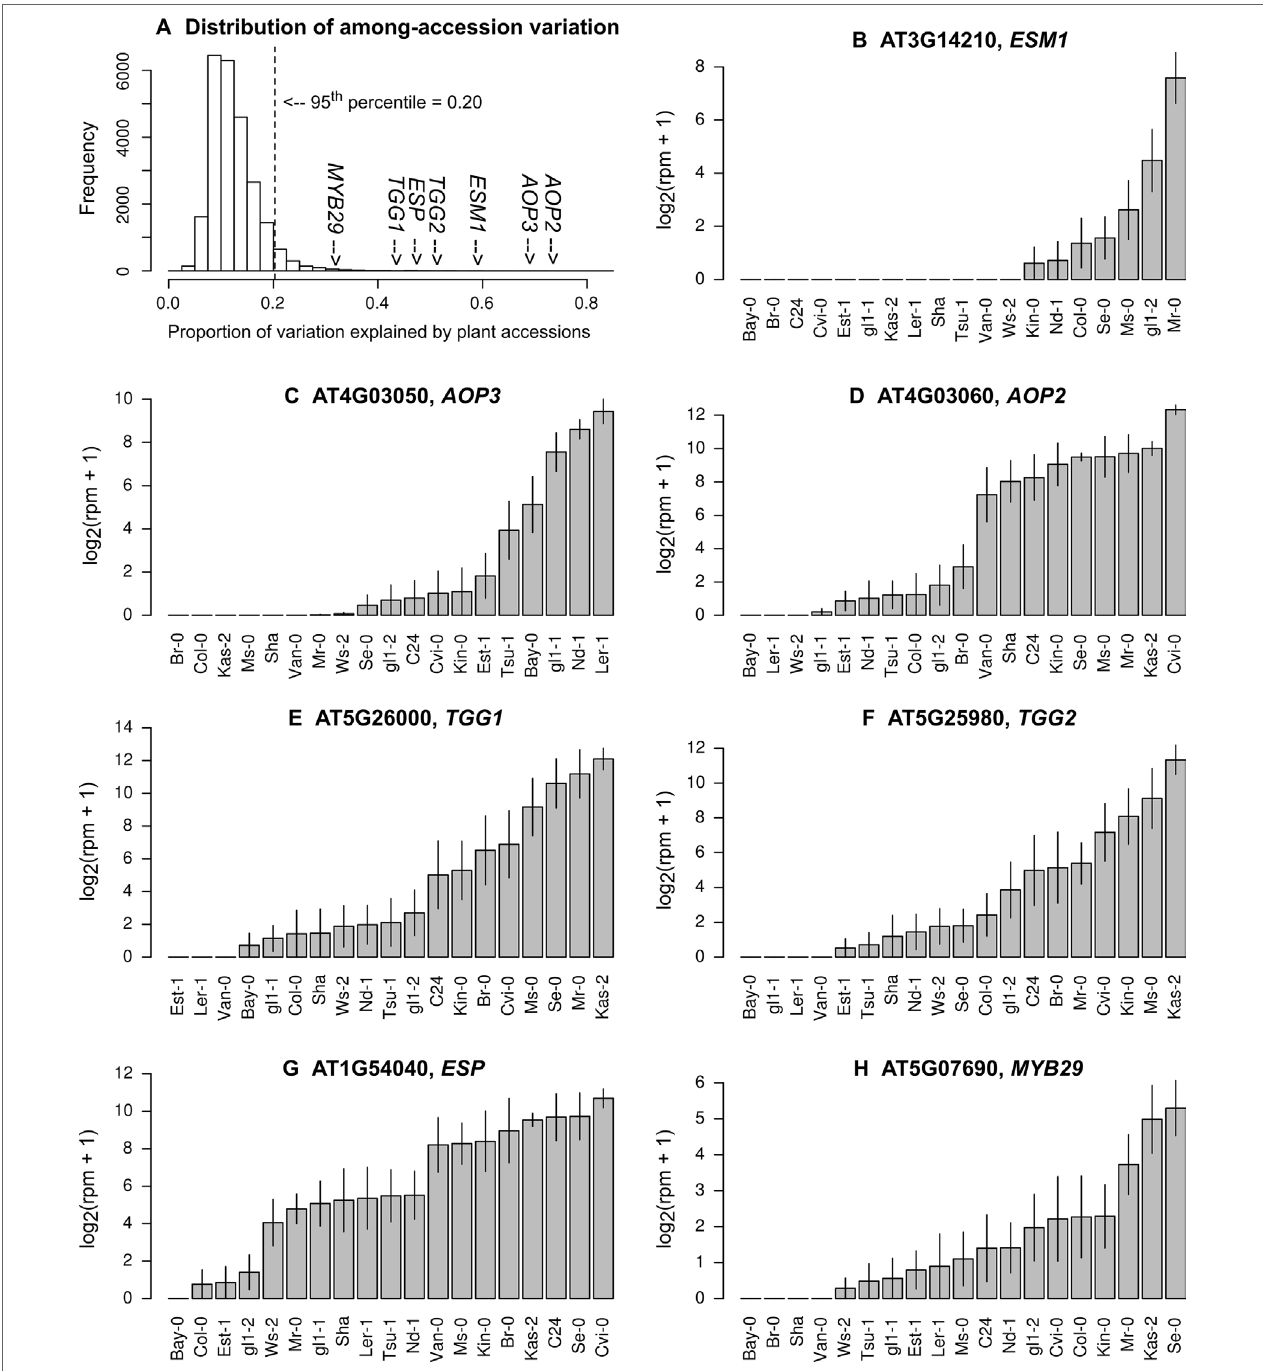
FIGURE 2 | Natural variation in the expression levels of genes involved in glucosinolate biosynthesis and hydrolysis. (A) Histogram showing the proportion of variation explained by plant accessions, (B) the expression of ESM1 , (C) AOP3 , (D) AOP2 , (E) TGG1 , (F) TGG2 , (G) ESP , and (H) MYB29 . Grey bars and vertical lines indicate mean ± SE. The list of the top 5% most variable genes is available in the Supporting Information ( Table S1